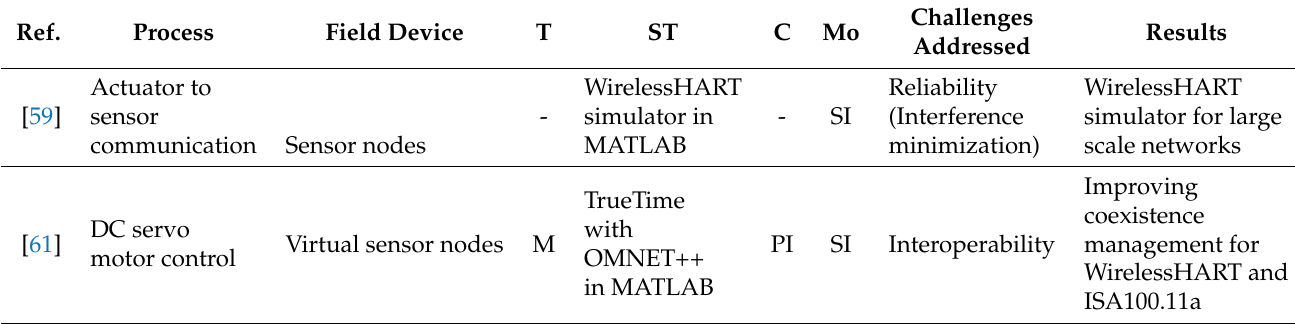
Table 7. Summary of WirelessHART for monitoring and control applications.